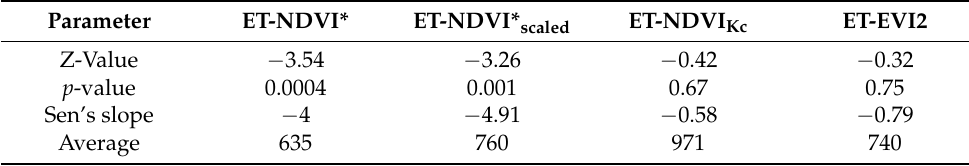
Table A1. Trend analysis of ET-VIs. Sen’s slope is in mm/year. The critical Z value at the 5% confidence level is ± 1.96, and there is a trend if the MK’s Z value is greater than the Z critical value. Otherwise, the trend is not statistically significant at the confidence level. Additionally, if the p -value is less than the significance level, the null hypothesis is rejected, meaning that there is a trend in the time series